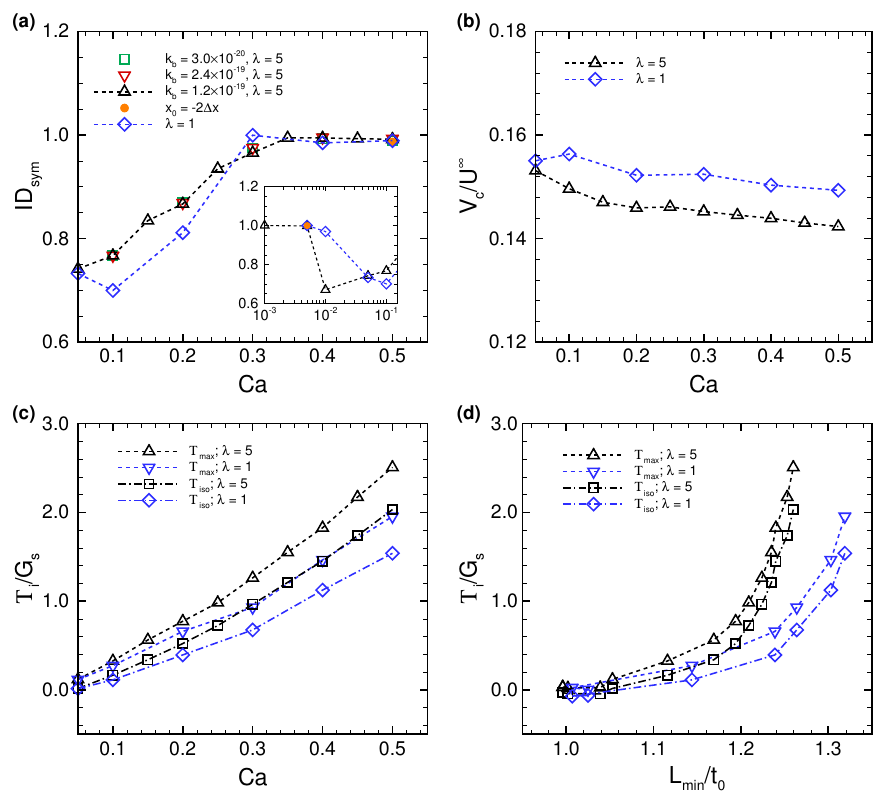
Figure 7. ( a ) The symmetry index ID sym as a function of Ca for different values of bending modulus k b = 3.0 × 10 − 20 J (square), 1.2 × 10 − 19 J (triangle), and 2.4 × 10 − 19 J (inverted triangle). The results obtained with a viscosity ratio of unity (i.e., λ = 1) are also displayed (diamond). The circular dot represents the result of x 0 = − 2 ∆ x at low Ca (= 5 × 10 − 3 ) and high Ca (= 0.5) and λ = 5. These results were obtained with k b = 1.2 × 10 − 19 J. ( b ) Time average of the RBC centroid velocity ( V c ) as a function of Ca for different viscosity ratios ( λ = 1 and 5). ( c ) Averaged maximum and isotropic tensions, T max and T iso , respectively. ( d ) Averaged tension T i as a function of the deformation index L min / t 0